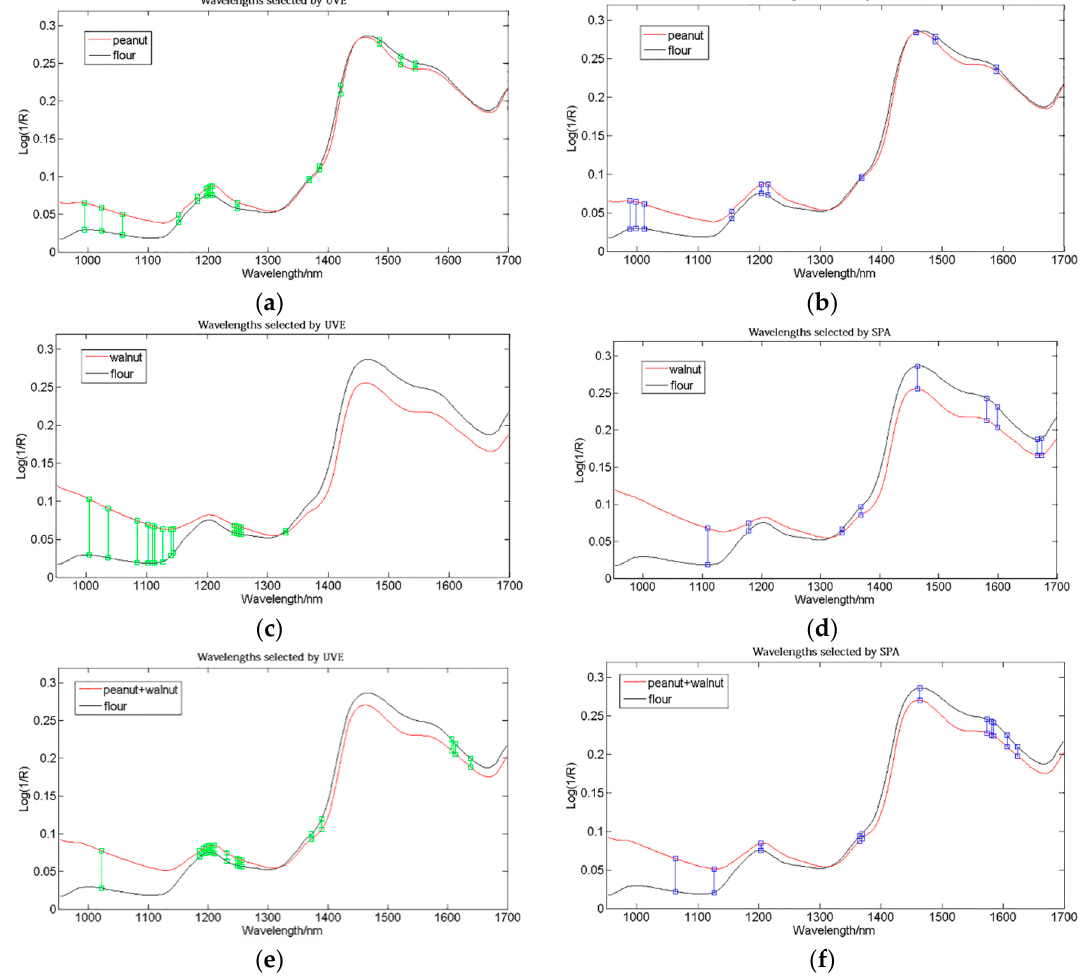
Figure 4. Distribution of feature wavelengths on average spectra curves of pure whole wheat flour as well as ( a , b ) peanut powder, ( c , d ) walnut powder, and combination of ( e , f ) both peanut and walnut powders samples (the wavelengths marked by the vertical green line were selected by UVE ( a , c , e ), while wavelengths marked by the vertical blue line were selected by SPA ( b , d , f )).